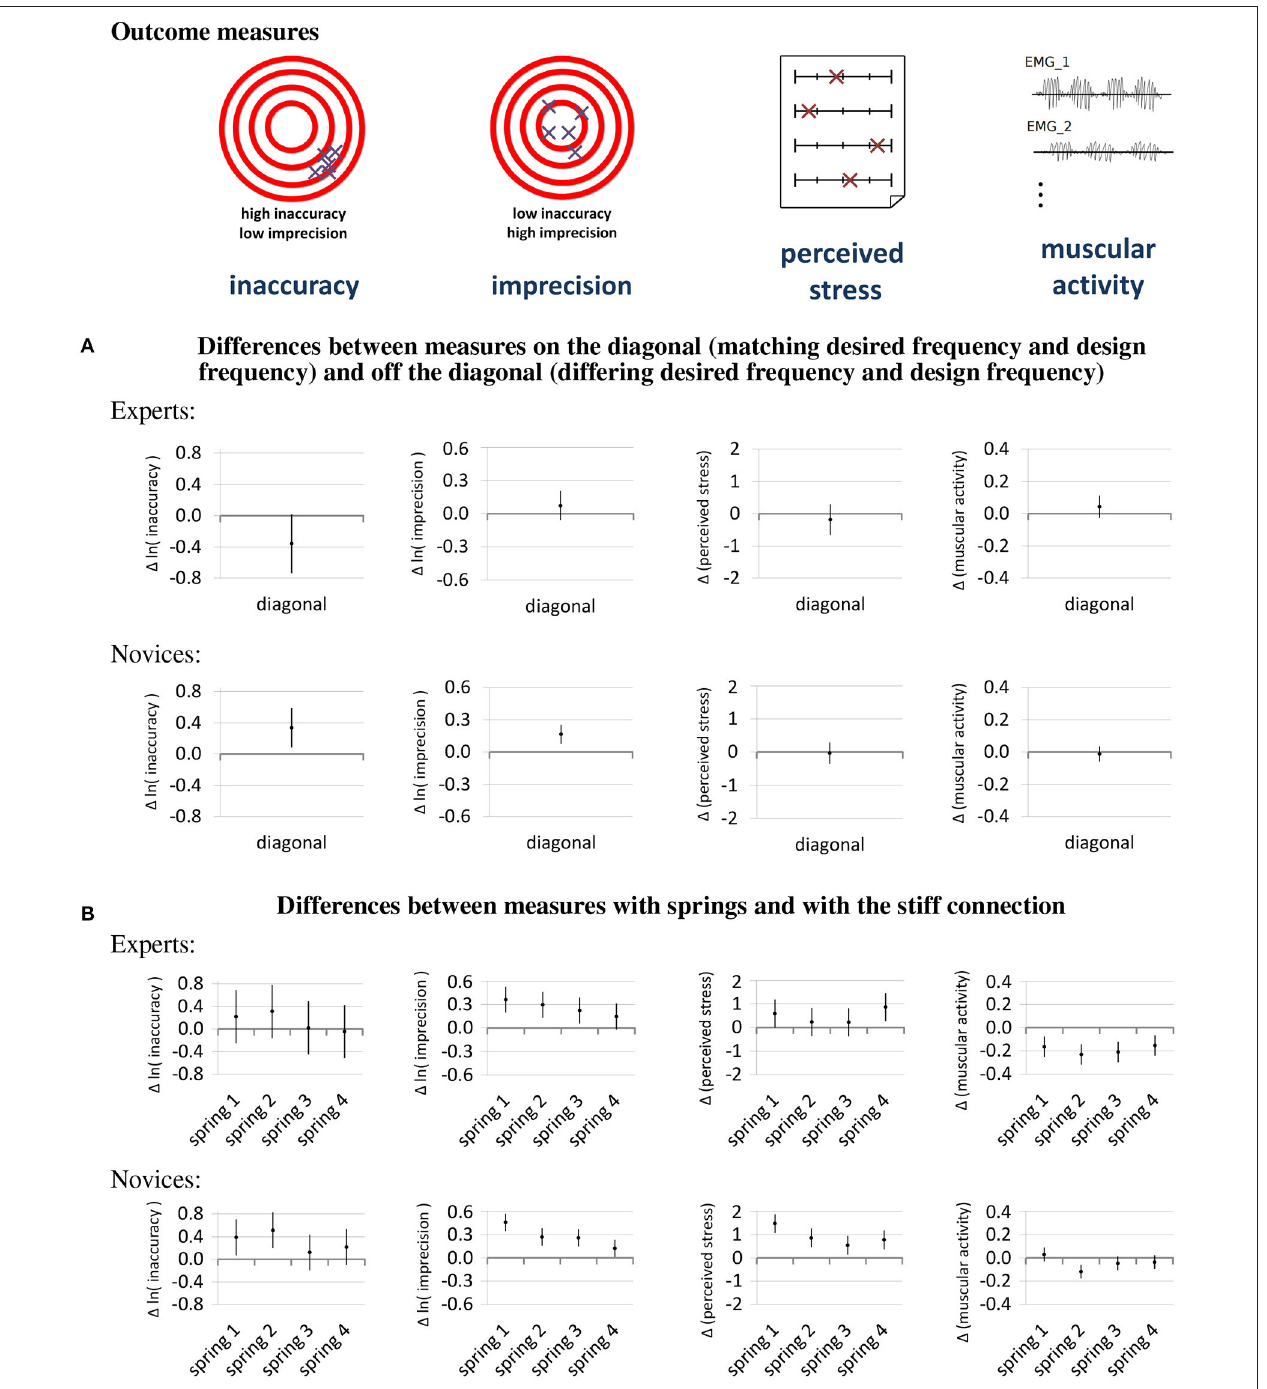
FIGURE 7 | Main results— The diagrams in this figure show how the four outcome measures are affected by the factors diagonal (A) and adapter type (B) . The dots in the diagram represent the estimates of the effects on the measures and the lines represent their 95% confidence intervals. For all outcome measures, lower values are